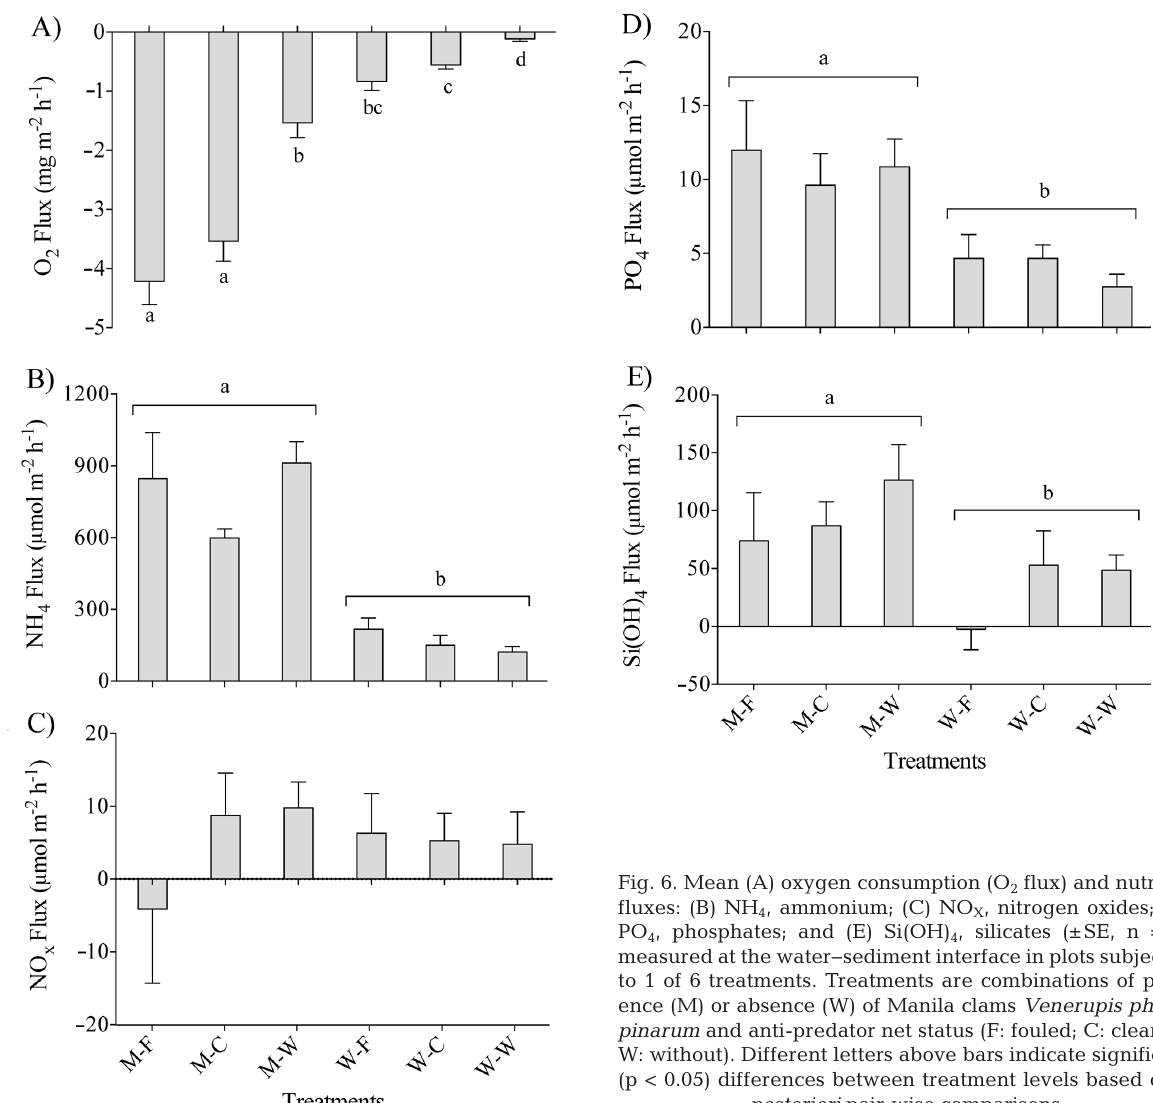
Fig. 6. Mean (A) oxygen consumption (O 2 flux) and nutrient fluxes: (B) NH 4 , ammonium; (C) NO X , nitrogen oxides; (D) PO 4 , phosphates; and (E) Si(OH) 4 , silicates (±SE, n = 8) measured at the water−sediment interface in plots subjected to 1 of 6 treatments. Treatments are combinations of pres- ence (M) or absence (W) of Manila clams Venerupis philip- pinarum and anti-predator net status (F: fouled; C: cleaned; W: without). Different letters above bars indicate significant (p < 0.05) differences between treatment levels based on a posteriori pair-wise